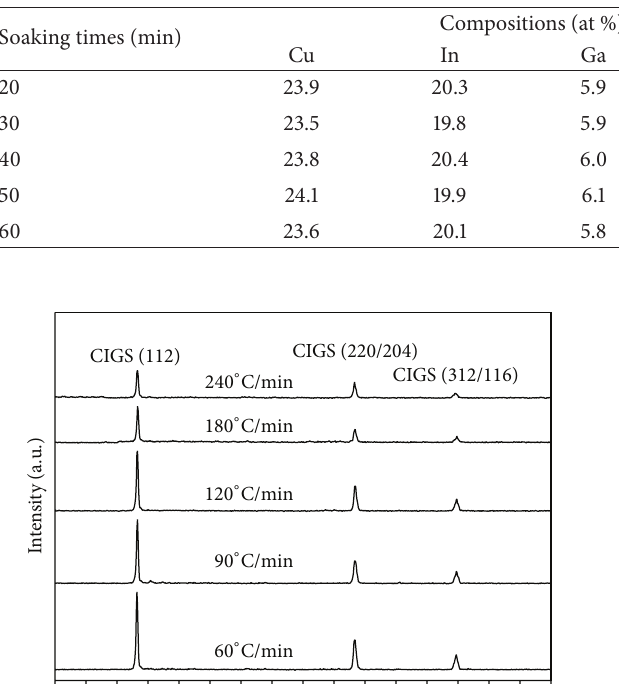
Table 1: The elemental composition of CIGS films.